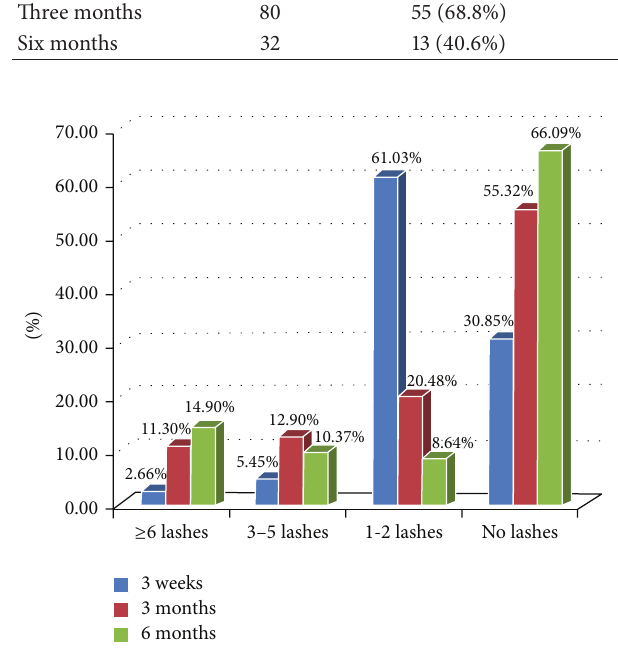
Figure 5: The outcome at each follow-up.